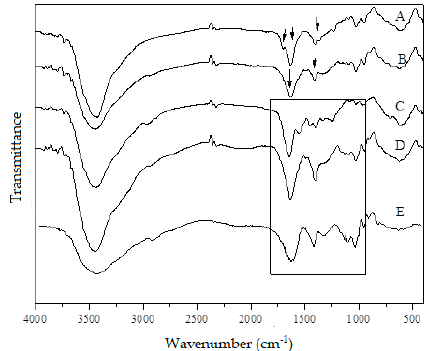
Figure 1. Ultraviolet-visible (UV–Vis) absorption spectra of sodium alginate, gelatin, and hydrogel with silver nanoparticles at di ff erent concentrations (1 mM, 2 mM, and 4 mM).